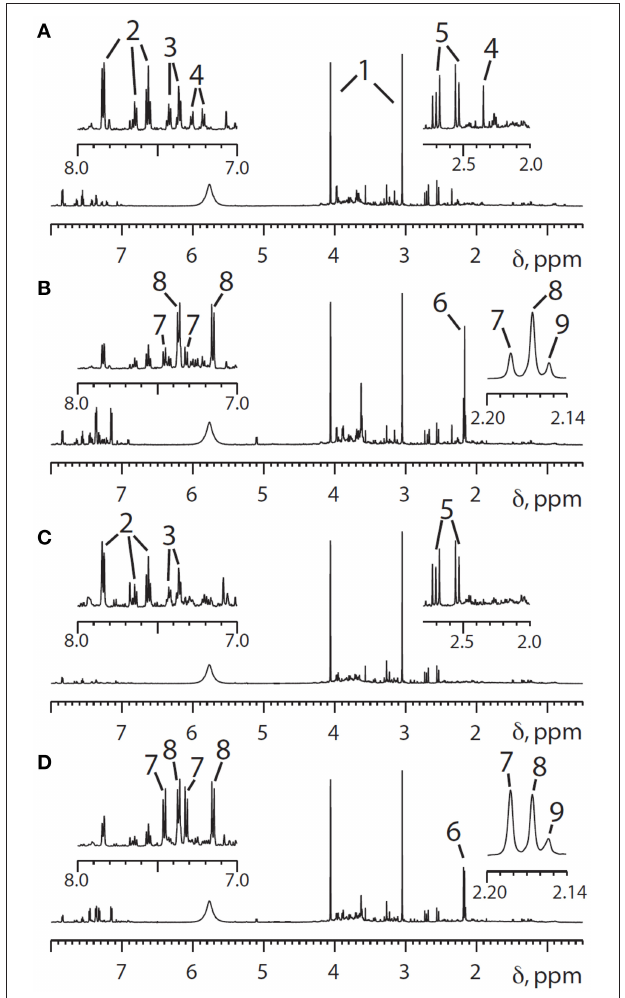
FIGURE 3 | 600 MHz 1 H NMR spectra of the urine from two different human volunteers in the region from 0.5 to 8.0 ppm, with expansion of the aromatic proton region (7.0–8.0 ppm) and a higher field region (2.0–2.8) shown above. (A) Pre-dose urine from volunteer 1; (B) 0–3 h post-dose NMR spectra from volunteer 1, The main differences between the pre-dose and post-dose spectra are the appearance of signals from paracetamol and its metabolites in both the aromatic and acetyl regions. (C,D) Corresponding pre- and post-dose spectra for volunteer 2. Key to peak